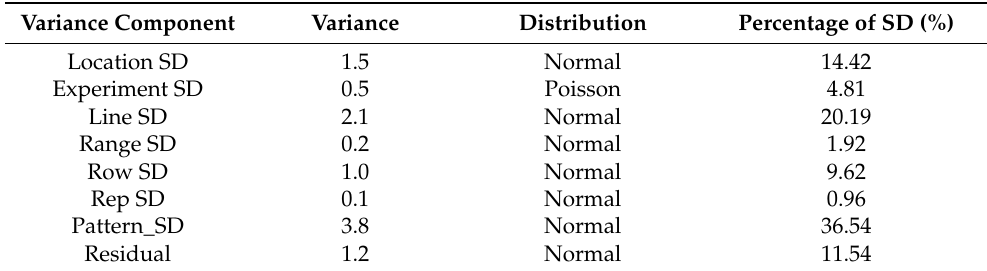
Table 2. Summary of parameters used for data simulation. The first column is the list of variance components; column 1: the indicated categories for reported variance or standard deviation (SD); columns 2, 3, and 4 are the variance values, the distribution used for the simulation, and the percentage of the variance components,